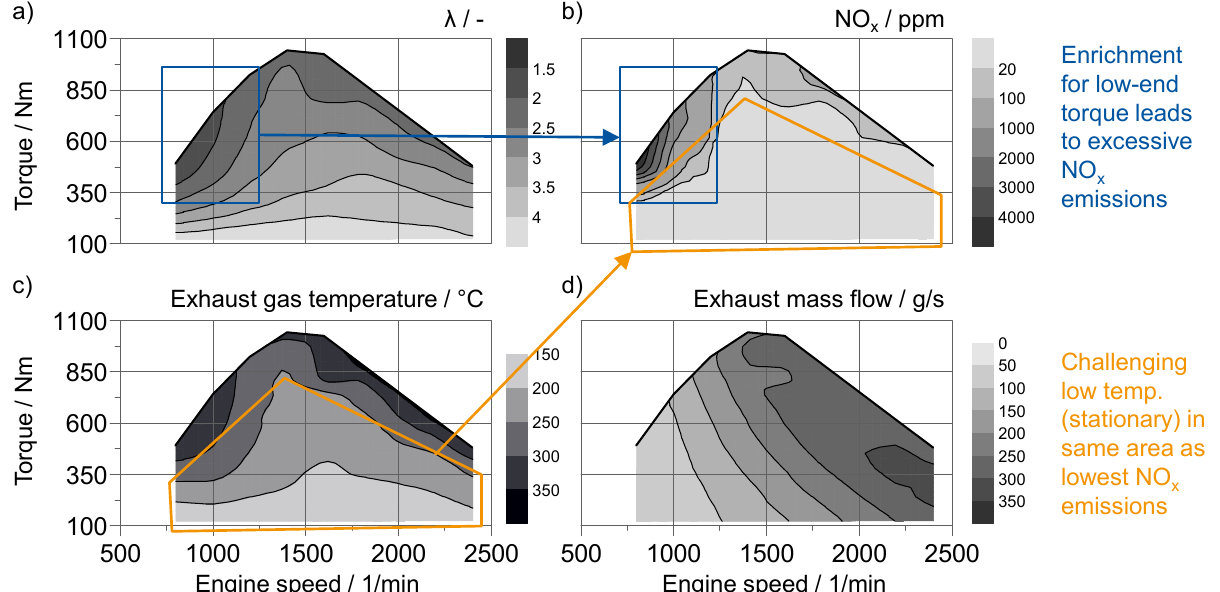
Figure 4. EATS boundary conditions with an efficiency orientated ultra-lean calibration: ( a ) Air-fuel ratio, ( b ) Nitrogen oxide emissions, ( c ) Exhaust gas temperature, ( d ) Exhaust gas mass flow. Here the load is expressed as engine torque.